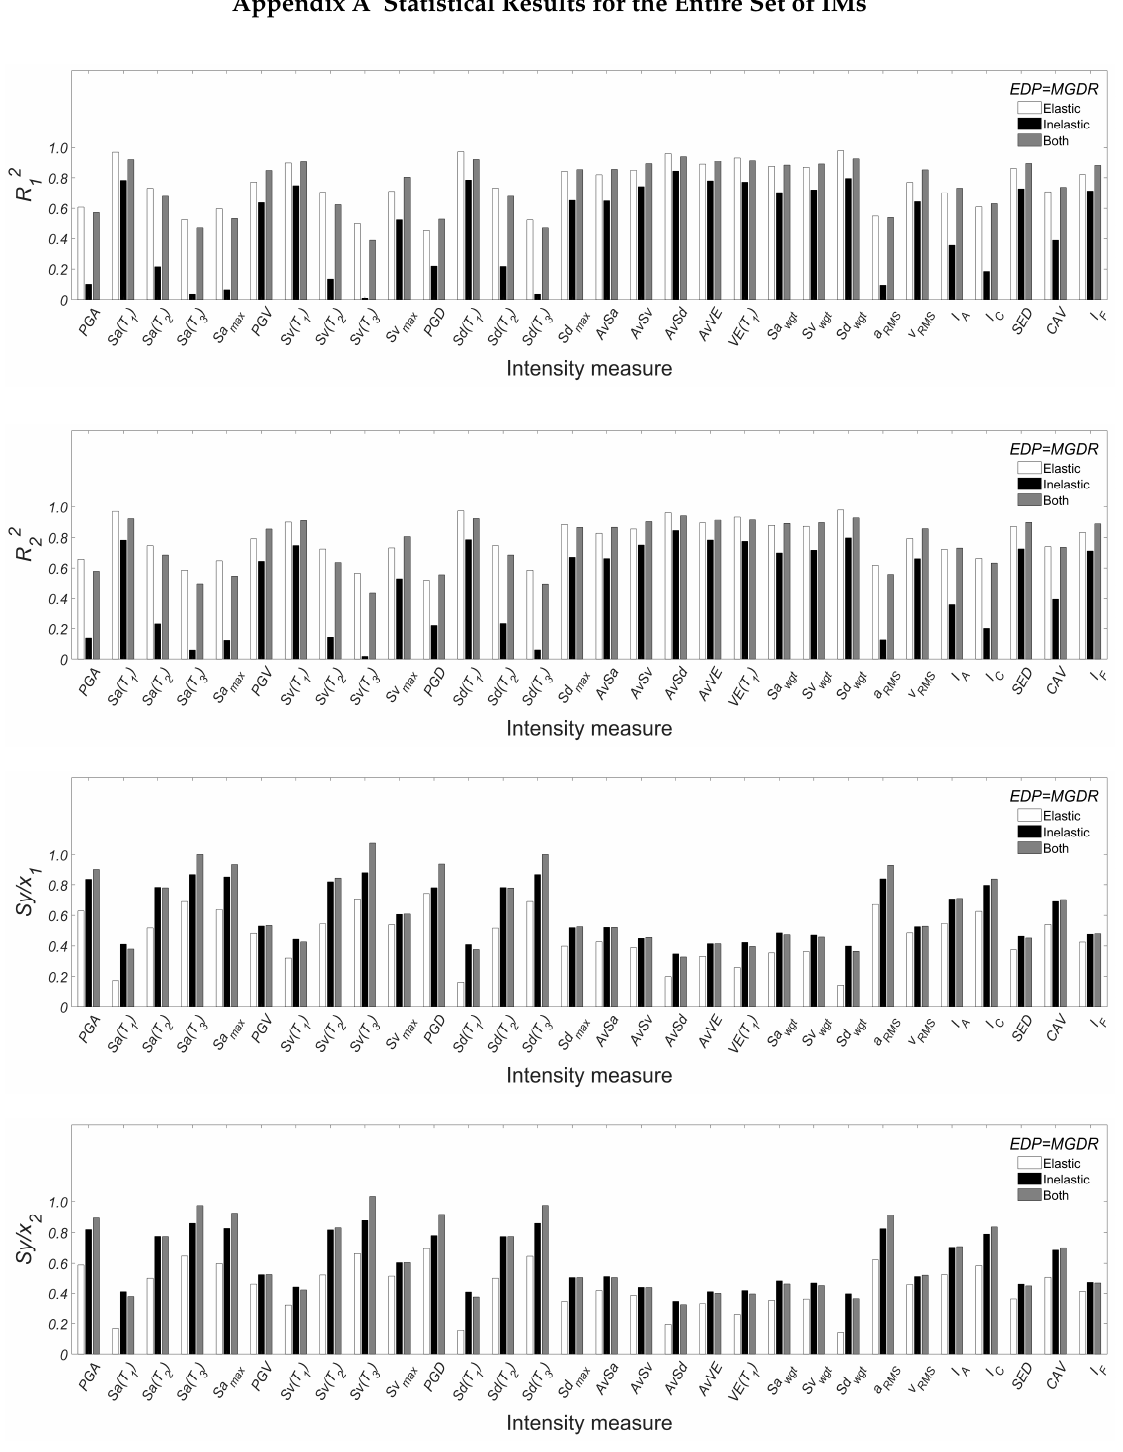
Figure A1. Statistical results by considering as EDP to MGDR.